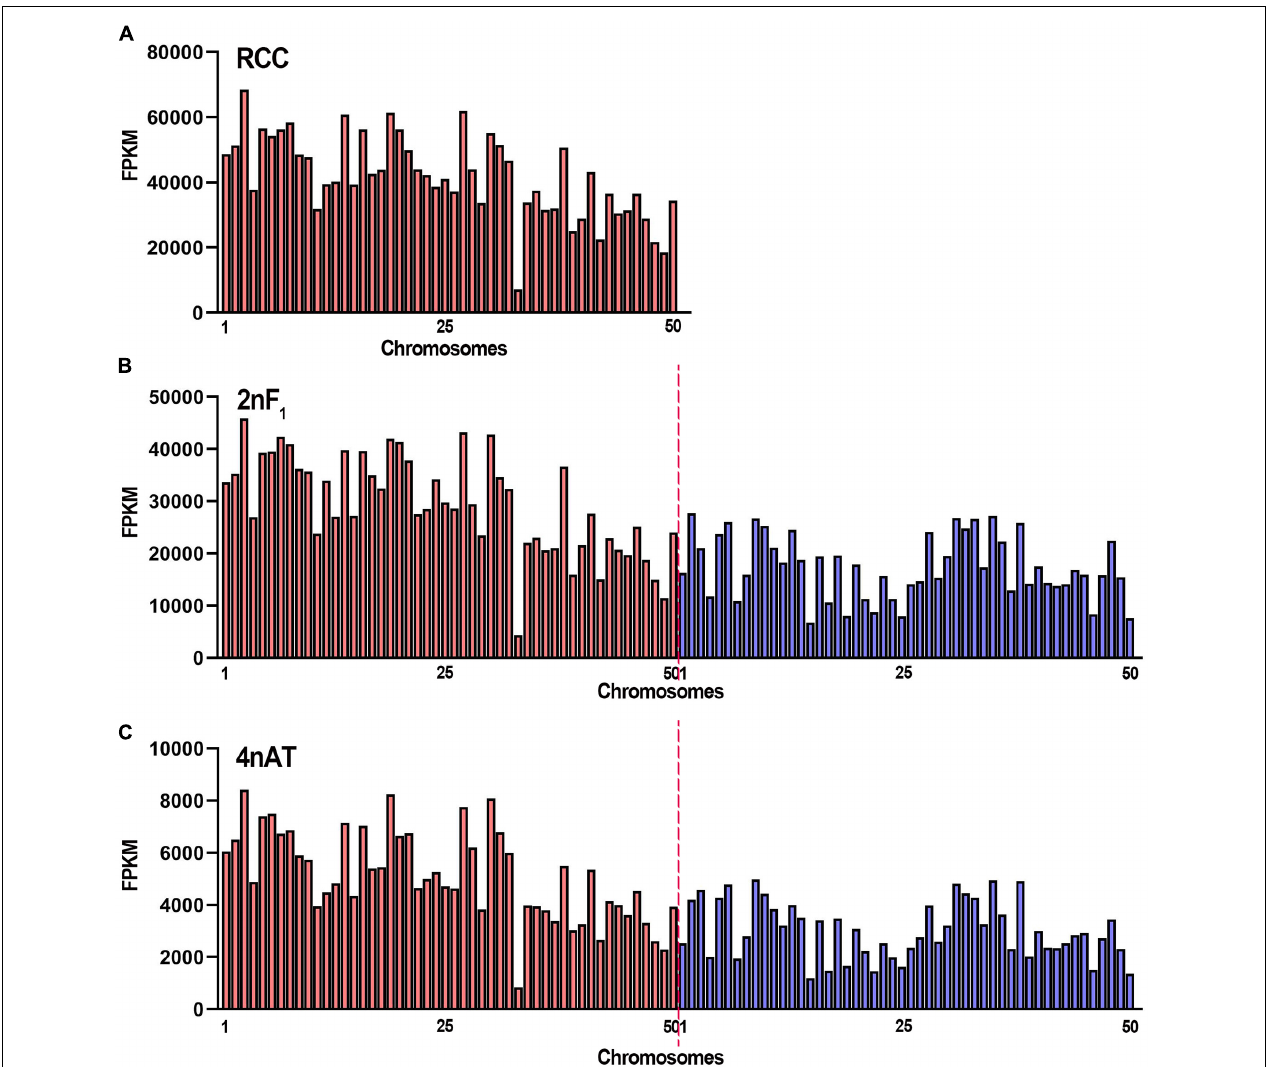
FIGURE 3 | The FPKM distribution of the chromosomes in RCC, 2nF 1 , and 4nAT. (A) Distribution of the FPKM from RCC testicular transcriptome in RCC chromosomes. (B) Distribution of the FPKM from 2nF 1 testicular transcriptome in chromosomes from RCC and common carp. (C) Distribution of the FPKM from 4nAT testicular transcriptome in chromosomes from RCC and CC. The red bars show the RCC chromosomes, and the blue bars show the CC chromosomes. The original data of distribution of the FPKM are shown in Supplementary Table 3 .